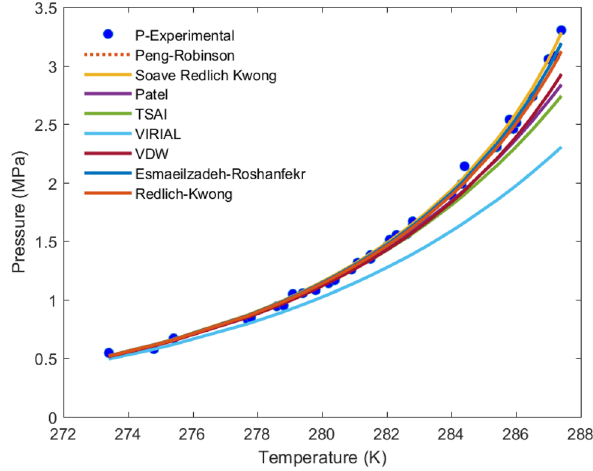
Fig. 4 Predicted pressure versus experimental plot for L region, AAD % [Min/Max] of [5.5/40.8]